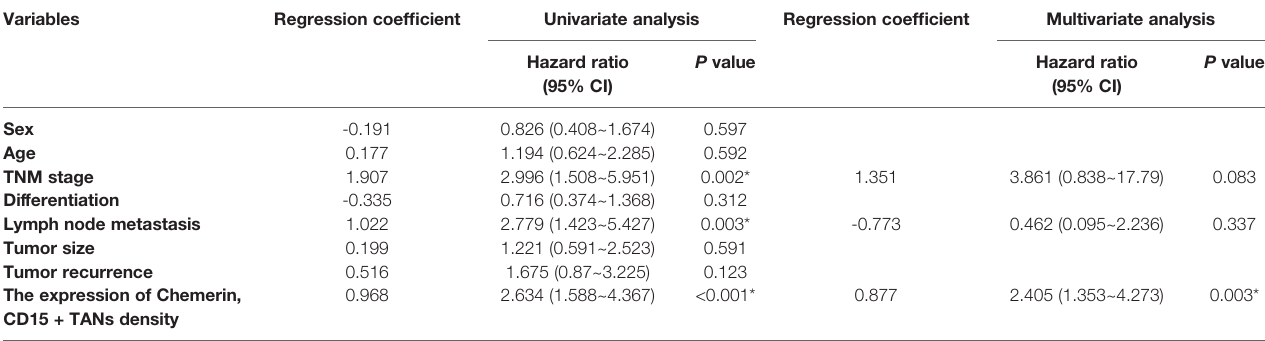
TABLE 4 | Univariate and multivariate disease-free survival analysis in OSCC patients.